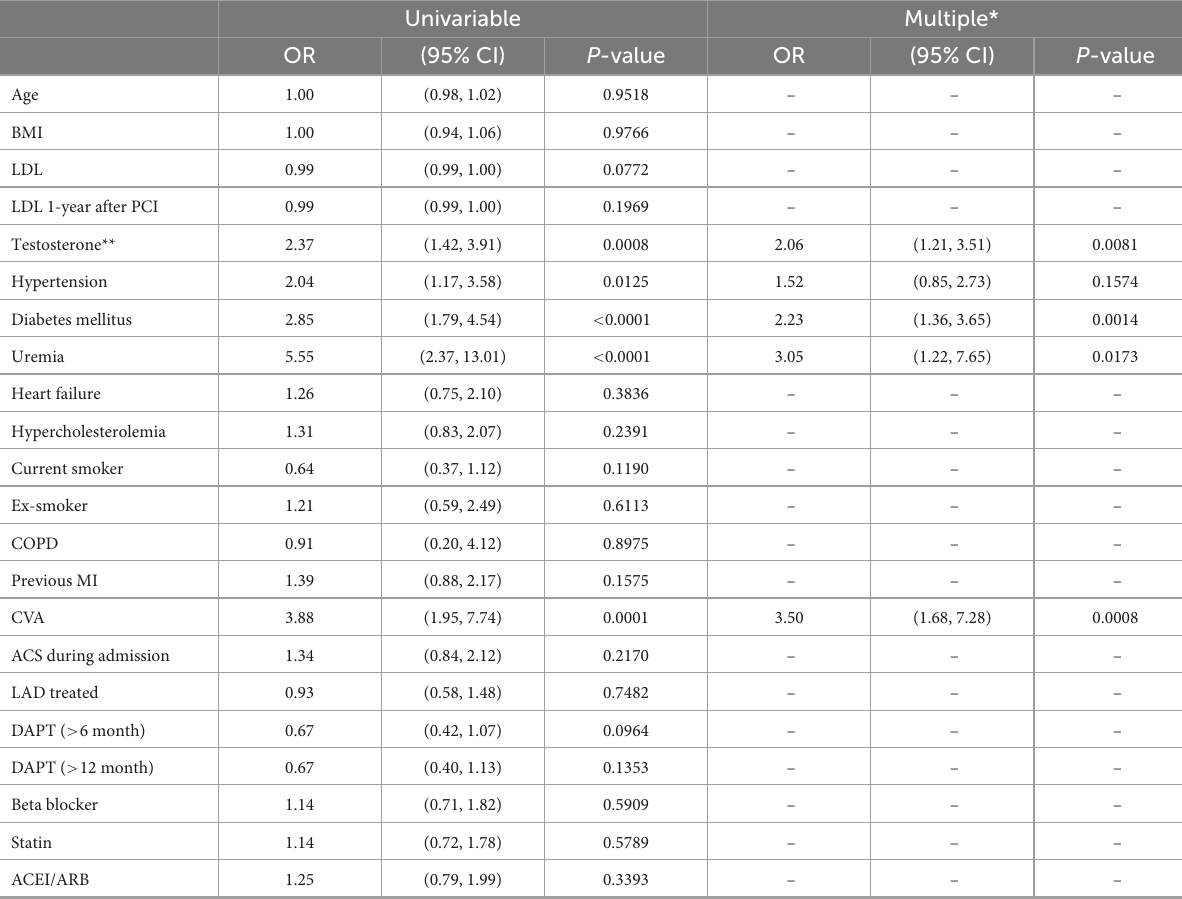
TABLE 1 Association between the characteristics of patients and major adverse cardiovascular event by univariable and multiple logistic regression. Univariable